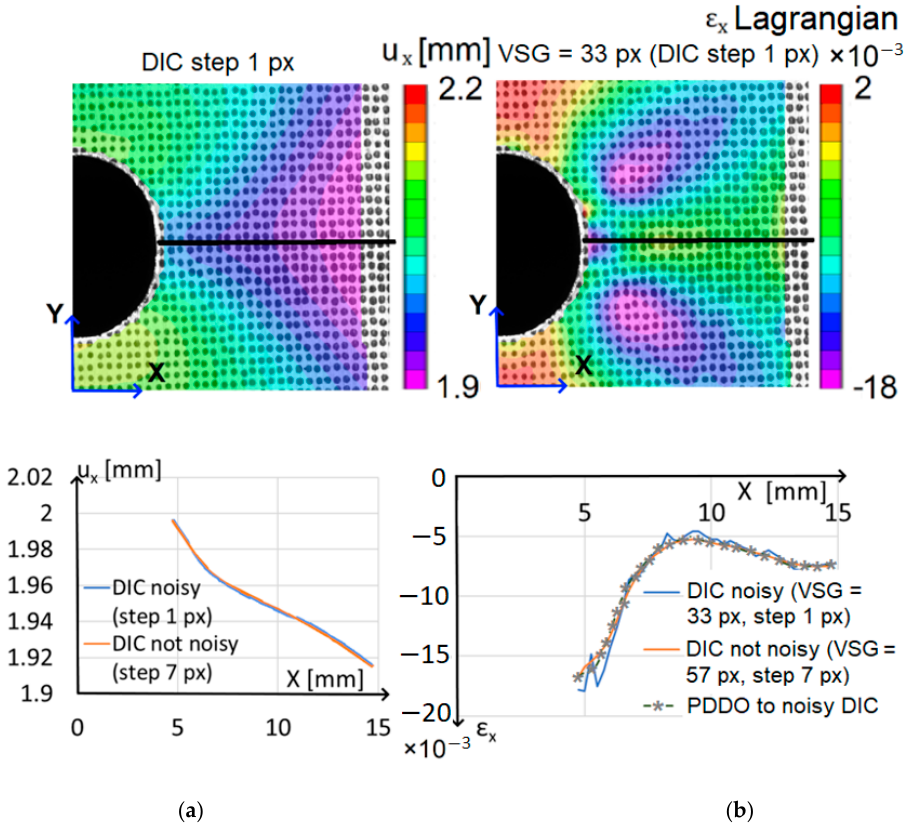
Figure 12. Slight oscillations (artificial noise) introduced in the DIC displacement ( a ), resulting in considerable noise in the DIC strains ( b ). considerable noise in the DIC strains ( b